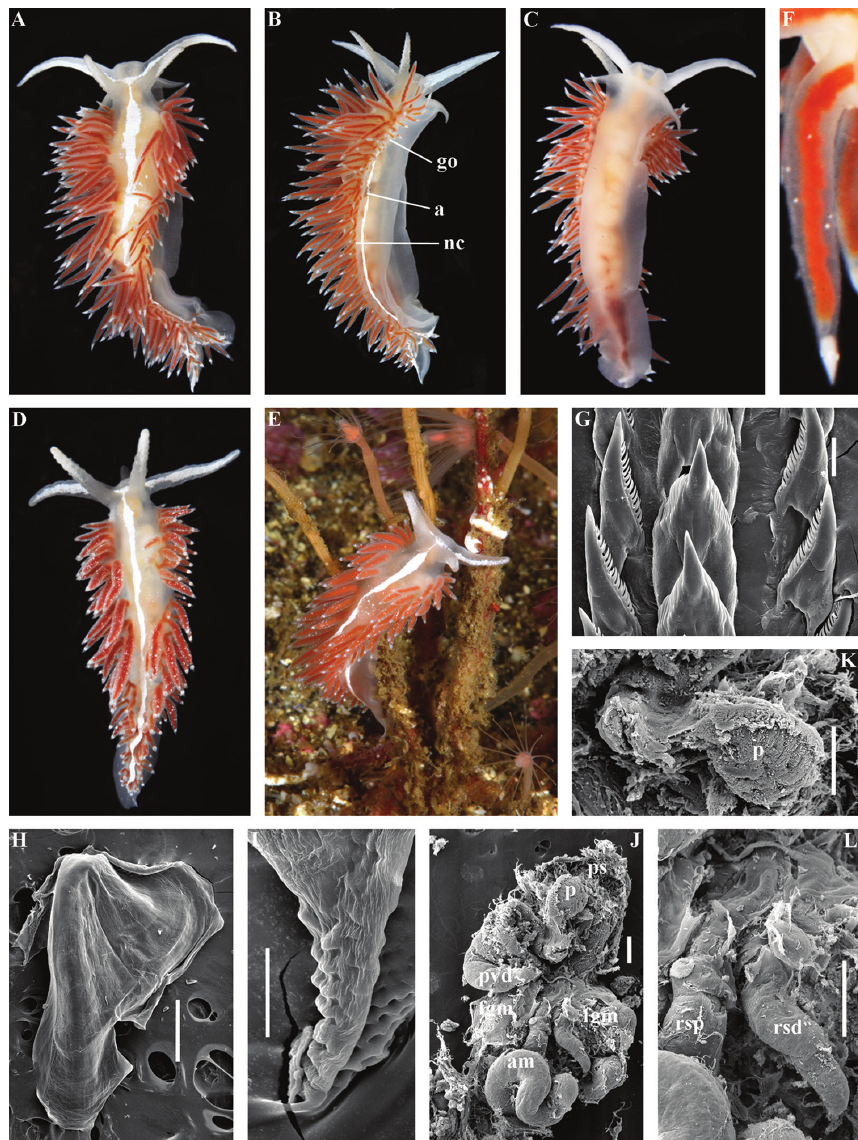
Figure 27. Gulenia orjani sp. n. Norwegian Sea, Gulen Dive Center. Holotype NTNU-VM-72482, living specimen 22 mm length: A dorsal view B lateral view C ventral view F details of cerata D Paratype ZMMU Op-538, living specimen 19 mm length, dorsal view E living specimens (not collected) on a hydroid colony G radular teeth, posterior part, SEM ZMMU Op-407 H jaw, SEM ZMMU Op-407 I details of masticatory process of jaw, SEM ZMMU Op-407 J reproductive system, SEM ZMMU Op-409 K penis, SEM ZMMU Op-409 L seminal reservoirs ZMMU Op-409. Abbreviations: a anus am ampulla fgm female gland mass go genital opening nc continuous notal edge p penis ps penial sheath pvd prostatic vas deferens rsd distal receptaculum seminis rsp proximal receptaculum seminis. Scale bars: G = 30 μm; H, J, K, L = 300 μm; I =30 μm. Photos and SEM images by T.A. Korshunova, A.V.